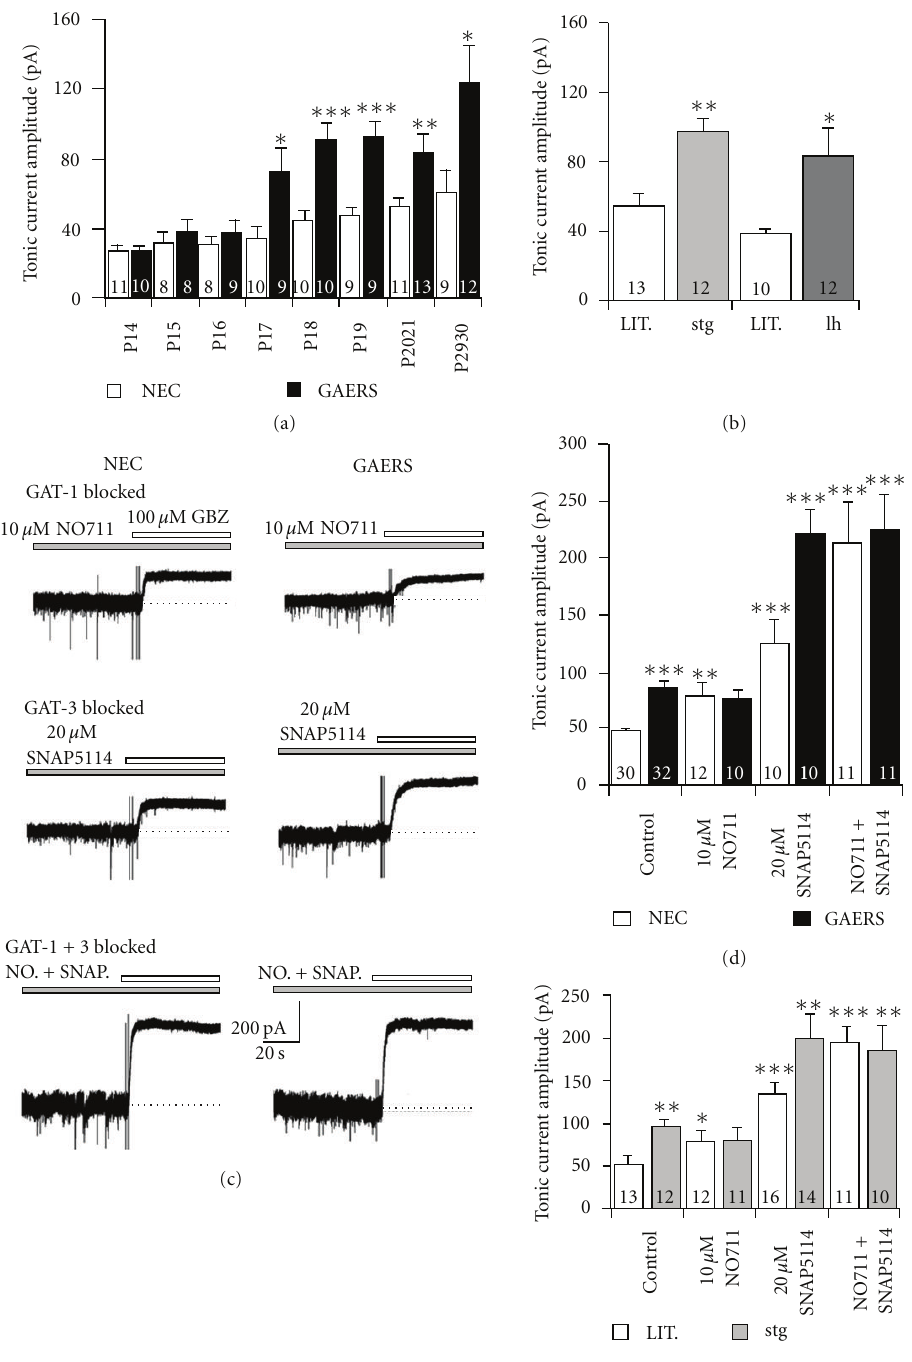
Figure 1: GAT-1 transporter dysfunction produces enhanced tonic GABA A currents in VB TC neurons in animal models of absence epilepsy. (a) The developmental profile of enhanced thalamic tonic current observed in GAERS animals compared to NEC. At P17 (prior to seizure onset), a significant increase in current amplitude is observed in the epileptic animal that remains elevated up to seizure onset (P30). (b) Tonic GABA A currents in VB TC neurons of monogenic stargazer (stg) and lethargic (lhour) mice are significantly greater than nonepileptic littermates after seizure onset. (c) Block of GAT-1 using NO711 in NEC animals elevates tonic current amplitude to levels similar to those observed in GAERS animals. No further enhancement of tonic current in GAERS is observed when GAT-1 is blocked. Block of GAT-3 produces significant increases in tonic current in both NEC and GAERS animals although the increase is smaller in NEC where GAT-1 remains functional. Simultaneous block of GAT-1 and GAT-3 results in very large tonic currents in both GAERS and NEC animals, which are not significantly di ff erent from each other. (d) Graph summarising the experiments depicted in (c). (e) Graph depicting the same series of experiments performed in stargazer mice illustrating the similar e ff ects in both models. ∗ P < 0 . 05, ∗∗ P < 0 . 01, ∗∗∗ P < 0 . 001. Number of recorded neurons for each condition is indicated in bars. (a–e) reproduced from